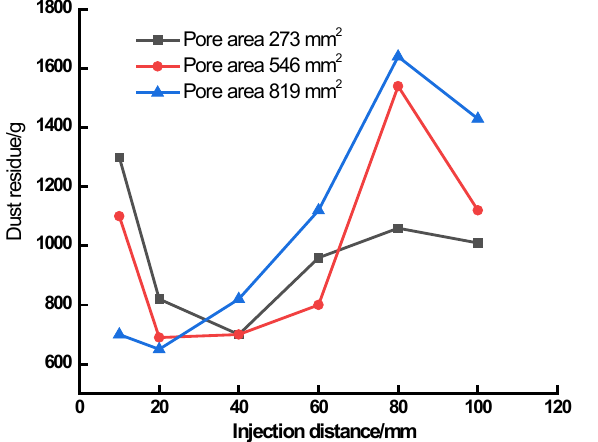
Figure 12. The dust residue of the cartridge with different nozzle areas and different jet distances at the pulse pressure of 0.4 MPa.